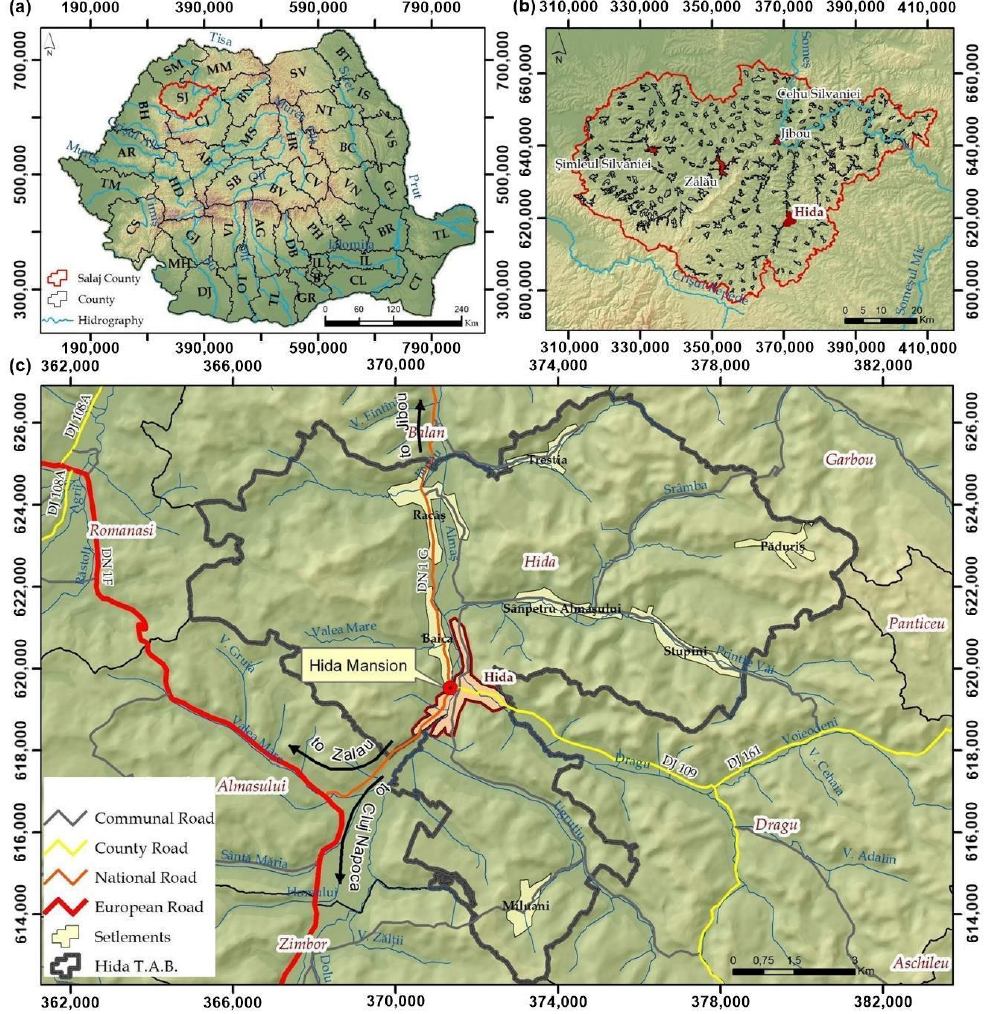
Figure 1. The geographic location of the study area ( a ) Romania map; ( b ) Sălaj County; ( c ) Hida administrative territorial unit.